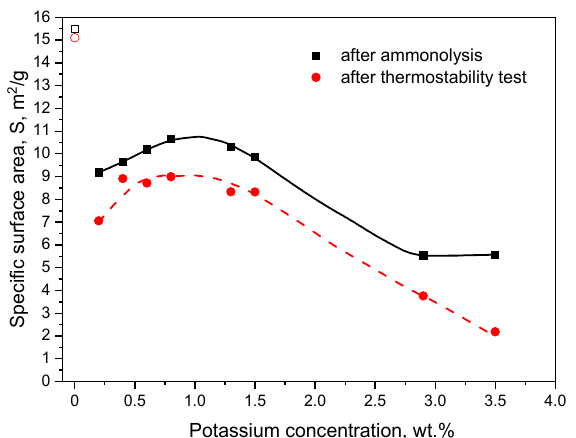
Figure 3. Specific surface area of COMON catalysts as a function of potassium concentration, measured after ammonolysis and after all catalytic tests. Lines are given for eye guidance.